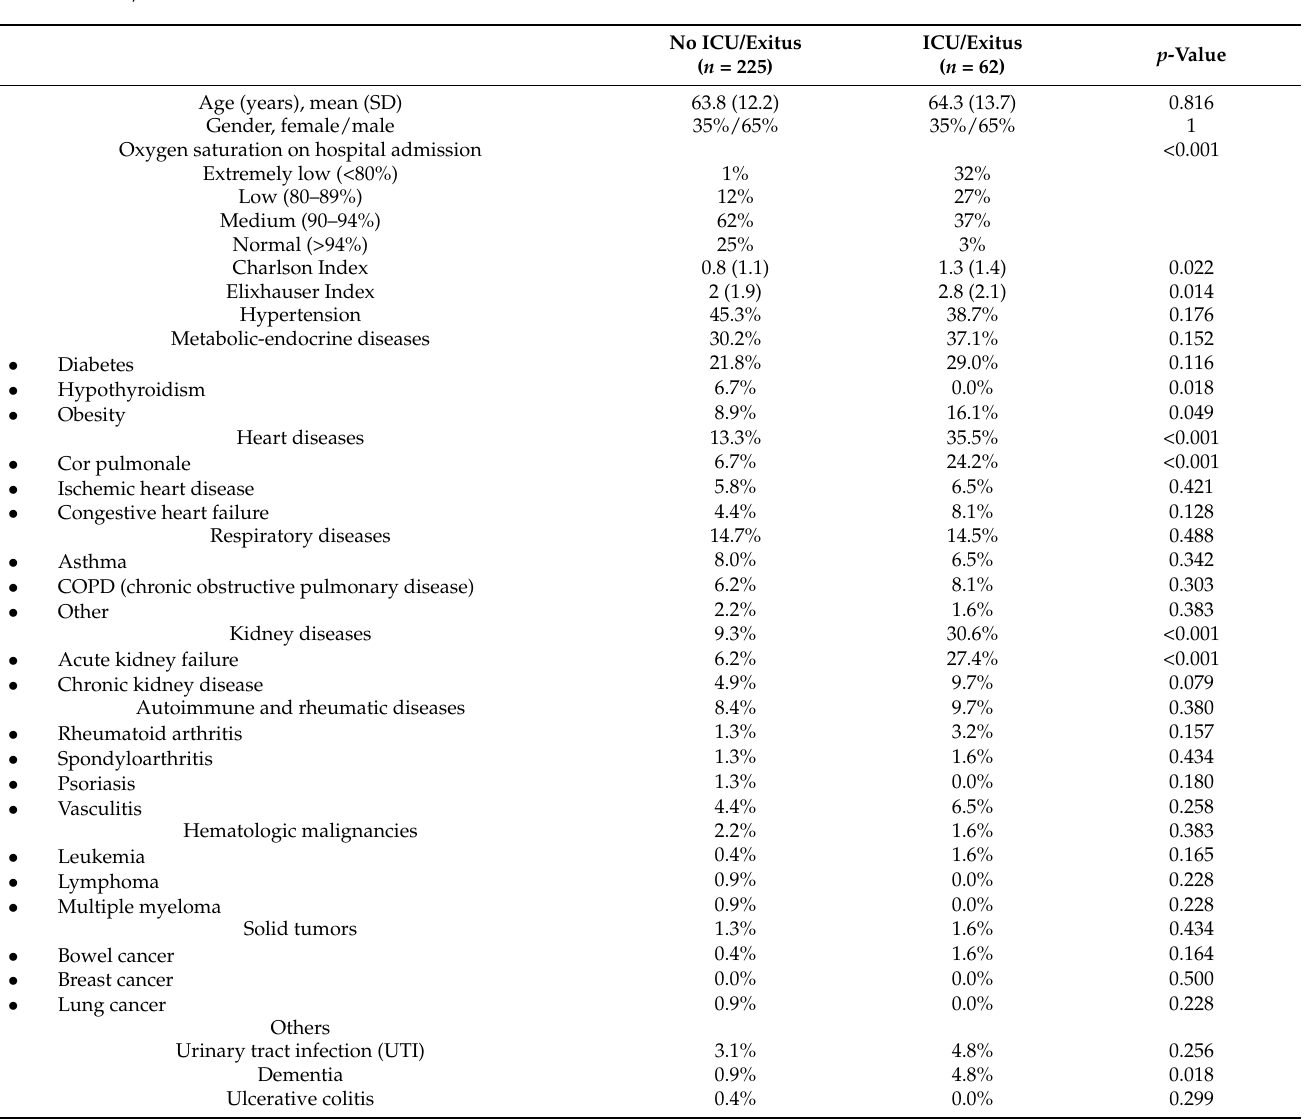
Table 1. Description of the COVID-19 patients included in the study. Demographic and clinical characteristics (mean and standard deviation) of the patients who survived and were not admitted to the ICU and those who were admitted to the ICU and/or died are